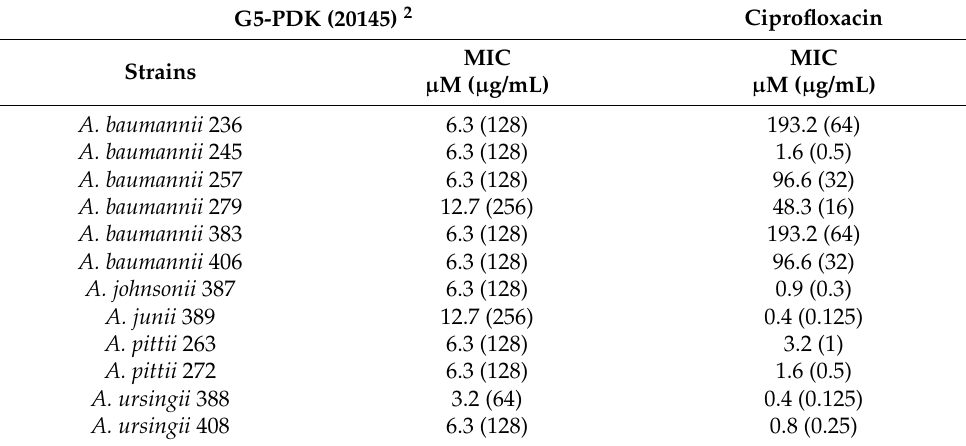
Table 4. MICs of G5-PDK obtained on isolates of the genus Acinetobacter from experiments conducted in triplicate 1 (expressed as µ M and as µ g/mL) compared to the MICs of ciprofloxacin. G5-PDK (20145) 2